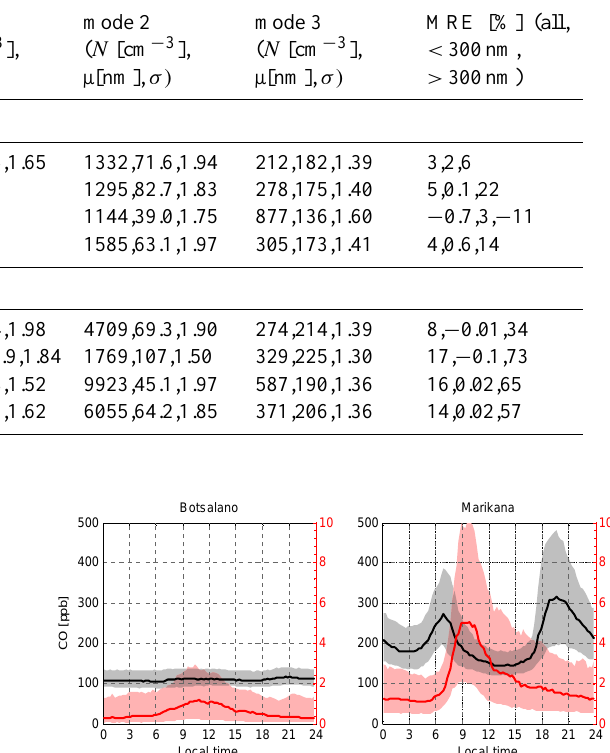
Table 3. Size distribution parameters for median distributions at 06:00, 12:00, 18:00 and 24:00LT for Botsalano and Marikana. Fractional concentrations